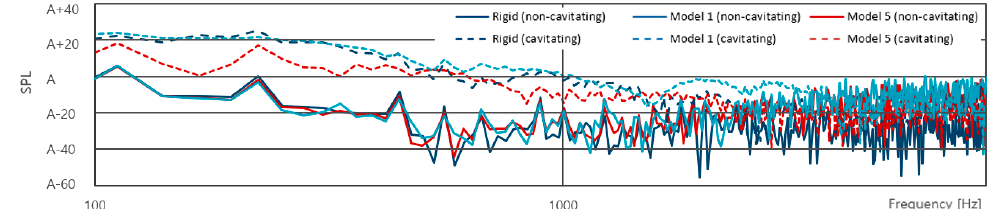
Figure 19. Sound pressure levels of rigid and composite propellers in non-cavitating and cavitating flows.